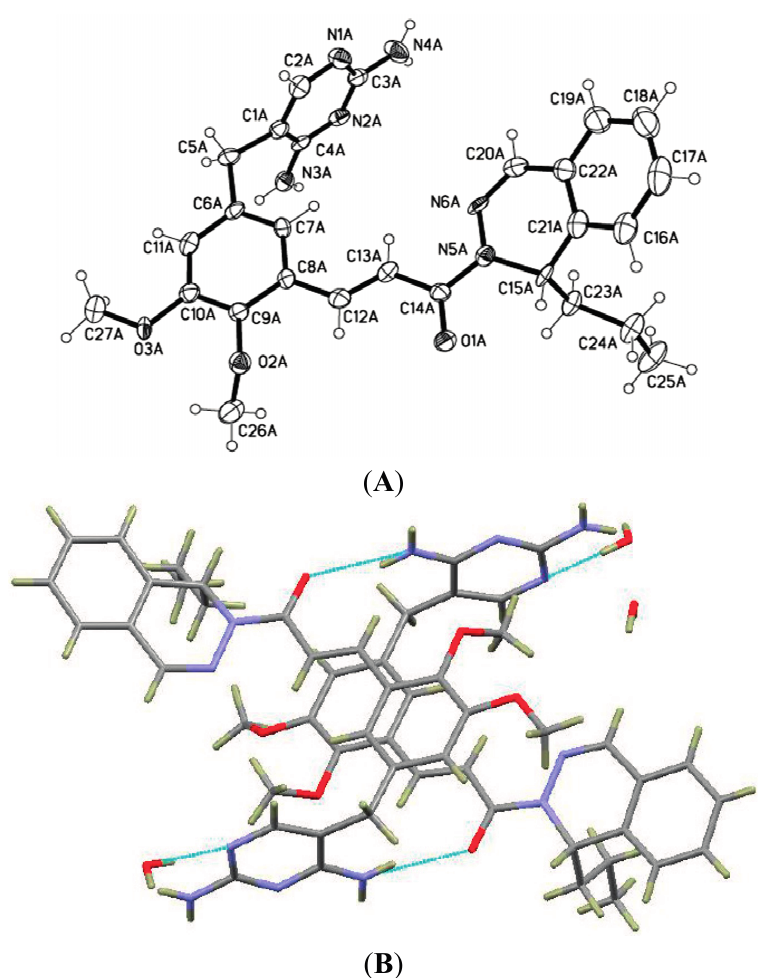
Figure 3. X-ray structure of ( S )- 3d [( S )-RAB1]: ( A ) Single molecule; ( B ) Unit